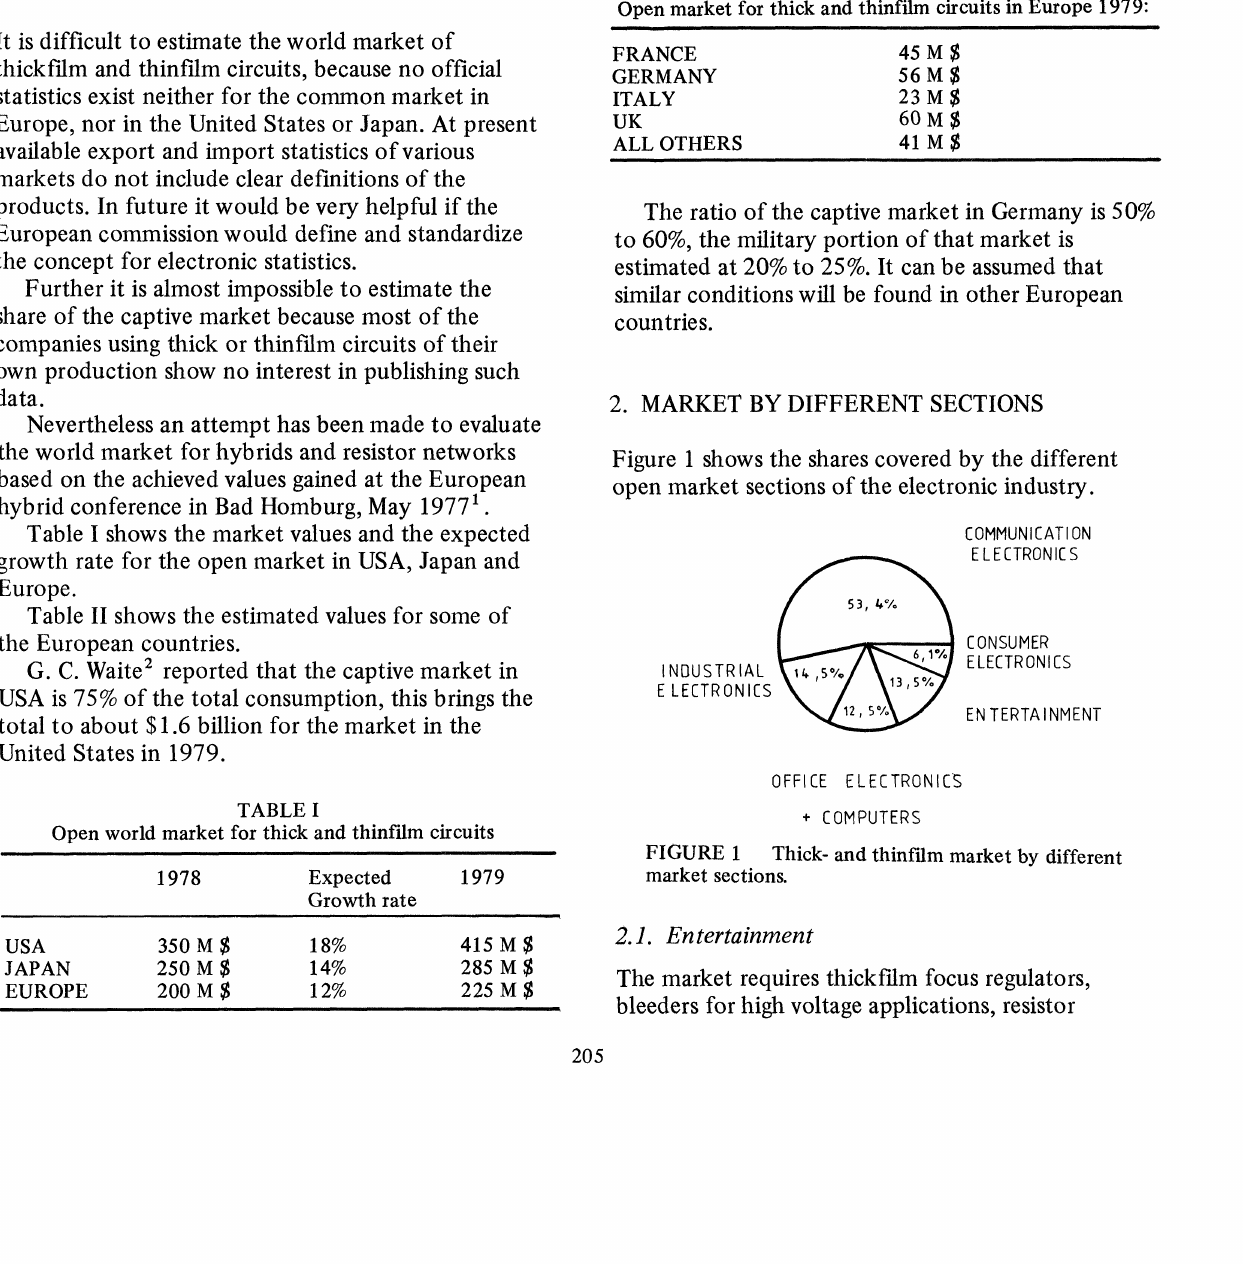
FIGURE Thick- and thinf’tlm market by different market